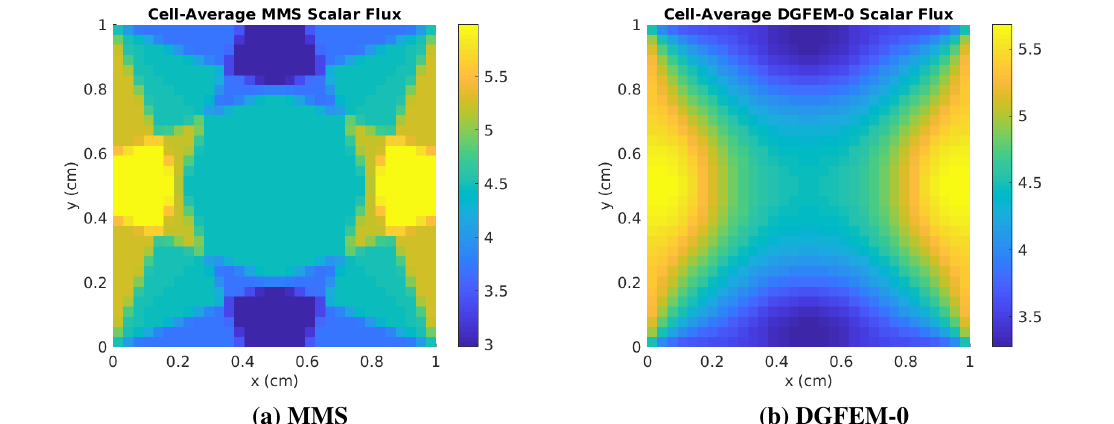
Figure 1: Cell-Average Scalar Flux for MMS-Derived Problem with Discontinuous